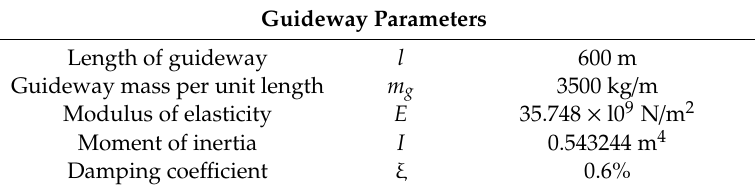
Table 2. Quantities characterizing the